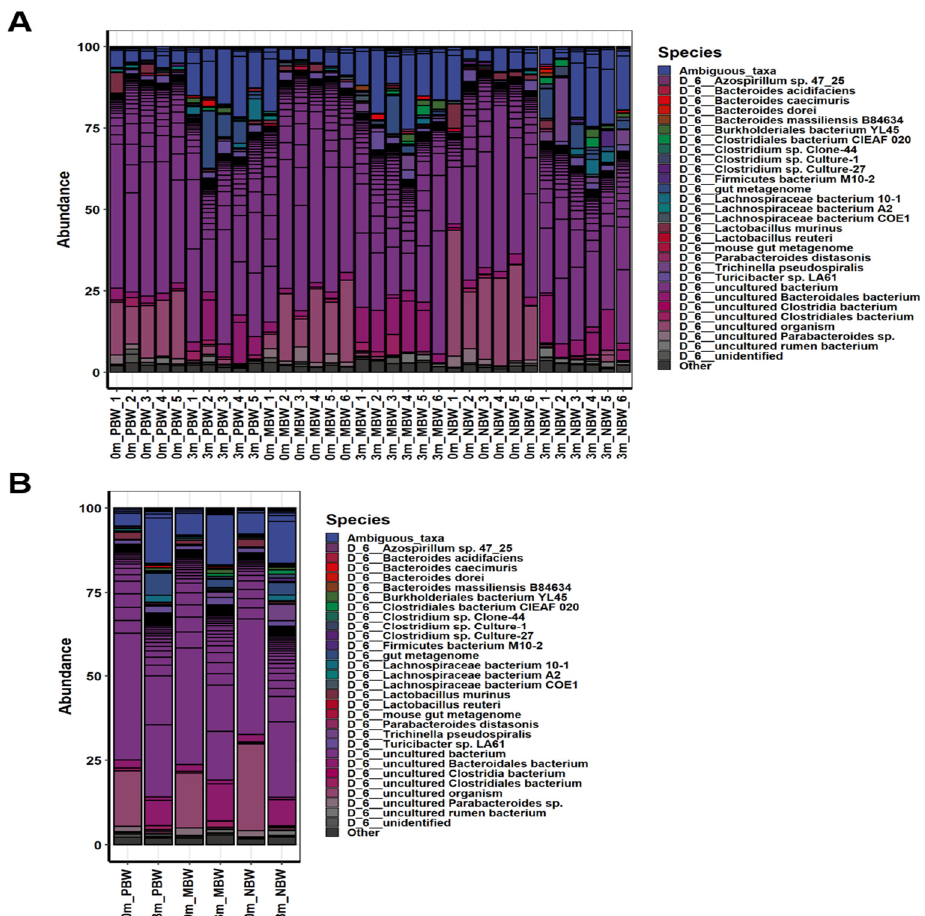
Figure 3. Compositional changes in the gut microbiome before and after the gut microbiome replacement. The relative compositional changes before and after the replacement in the gut microbiome at the species level for PBW, MBW, and NBW groups are shown. ( A ) Abundance values of individuals belonging to each group. ( B ) The average abundance values of each group.